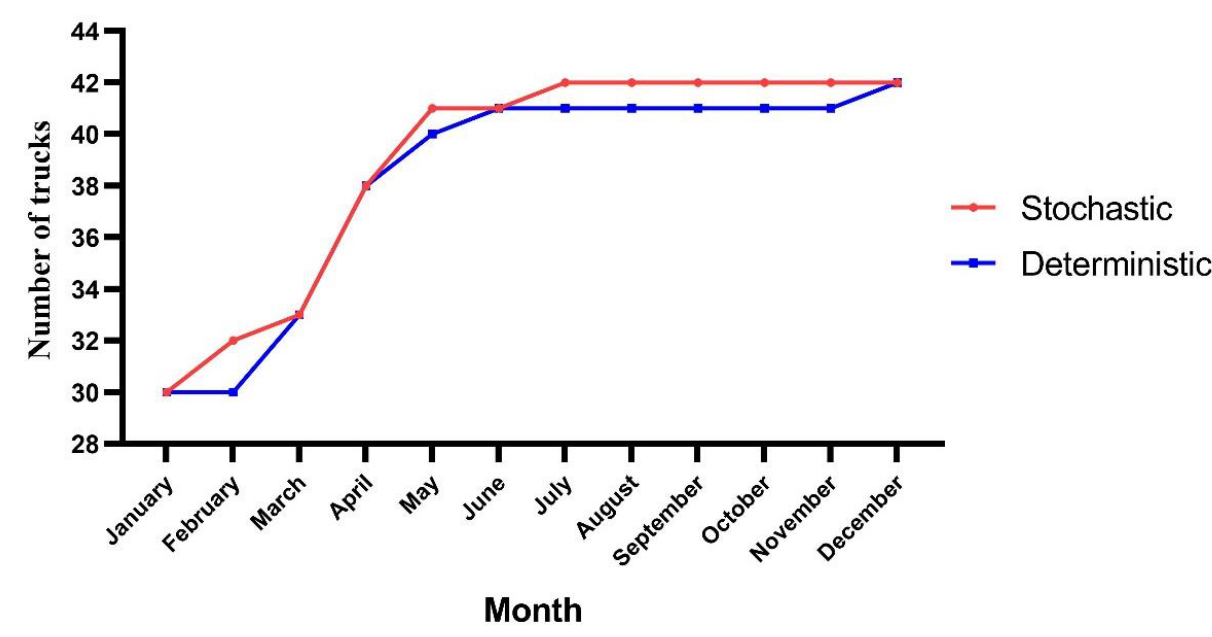
Figure 14. Number of required trucks in the stochastic and deterministic models.